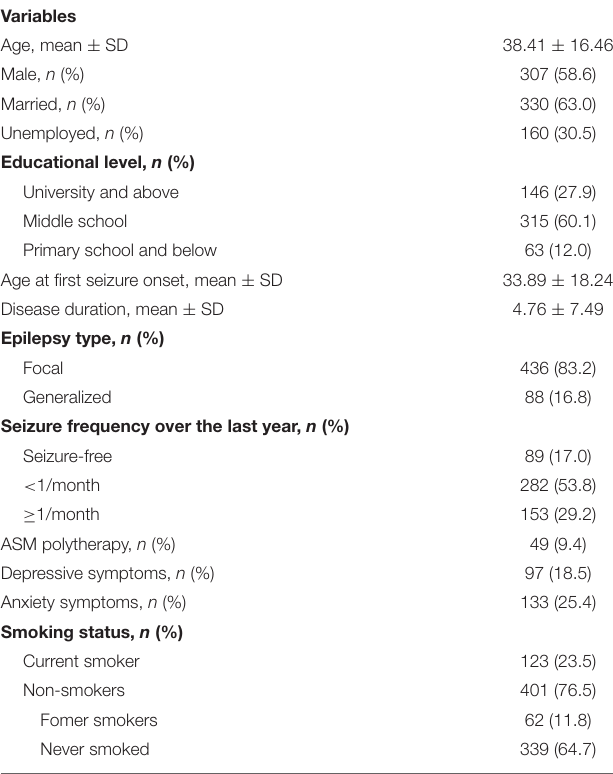
TABLE 1 | Patient